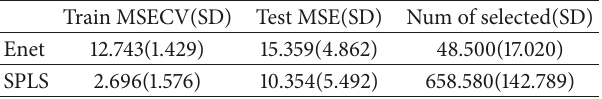
Table 5: The results on “buckwheat” data set based on 100 replica-